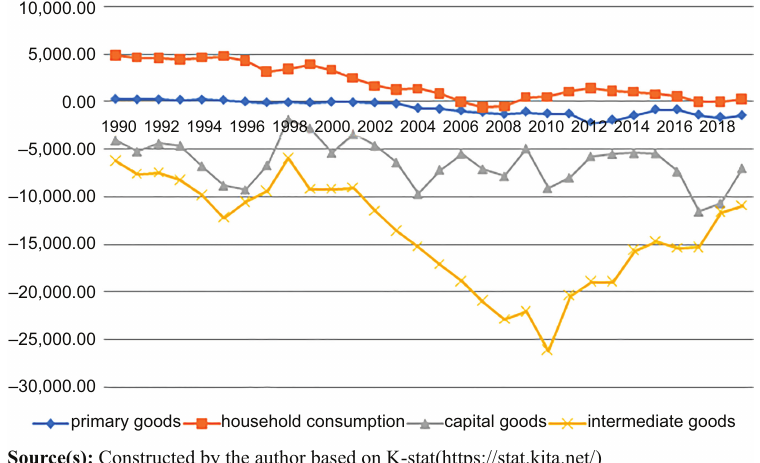
Figure 7. Korea-Japan trade balances by processing stages